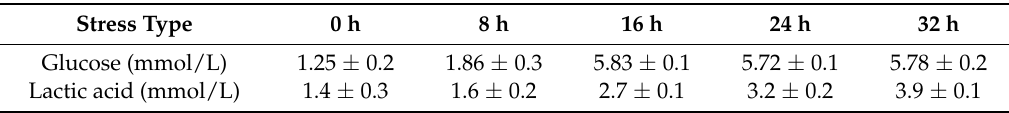
Table 4. Changes of key stress factors during